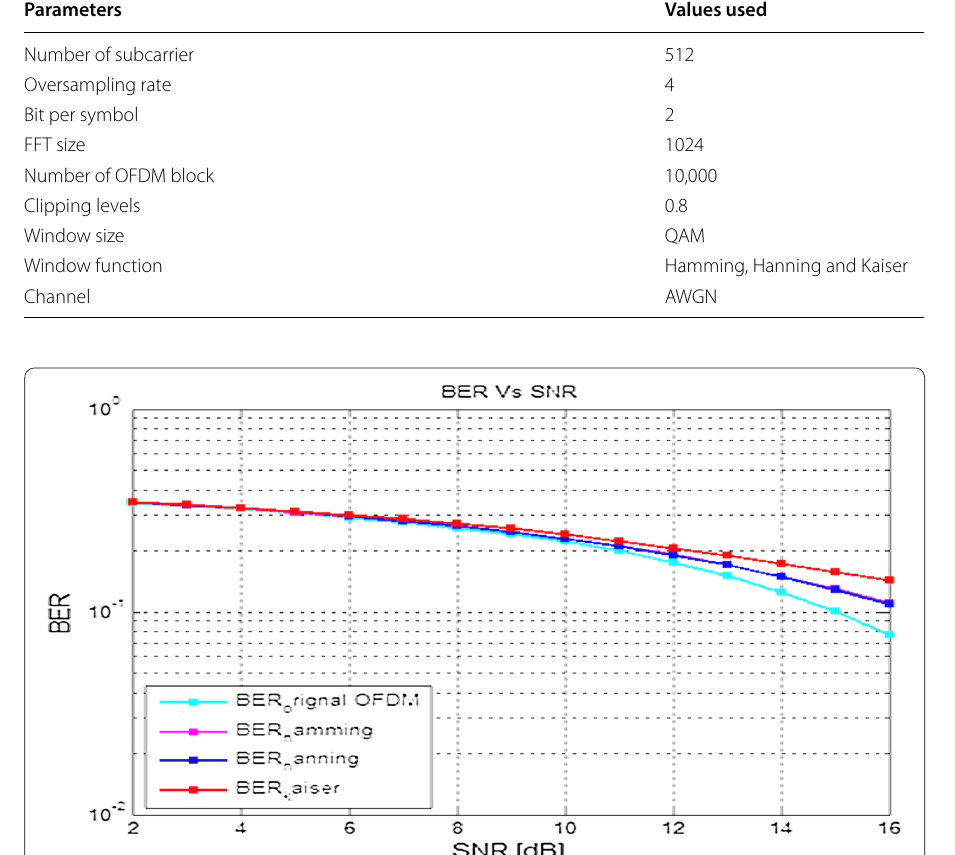
Fig. 6 BER performance for different windowing from the result